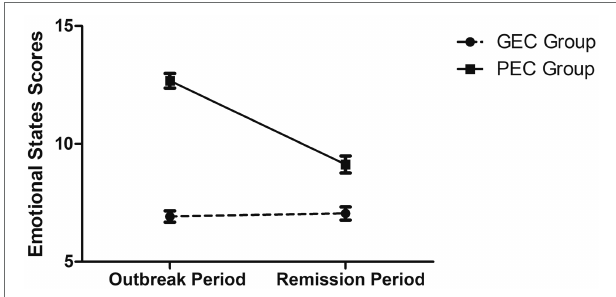
FIGURE 2 | Scores of emotional states in the outbreak and remission periods for the Good Emotional Coping (GEC) group and the Poor Emotional Coping (PEC) group. Error bar presents standard error of the